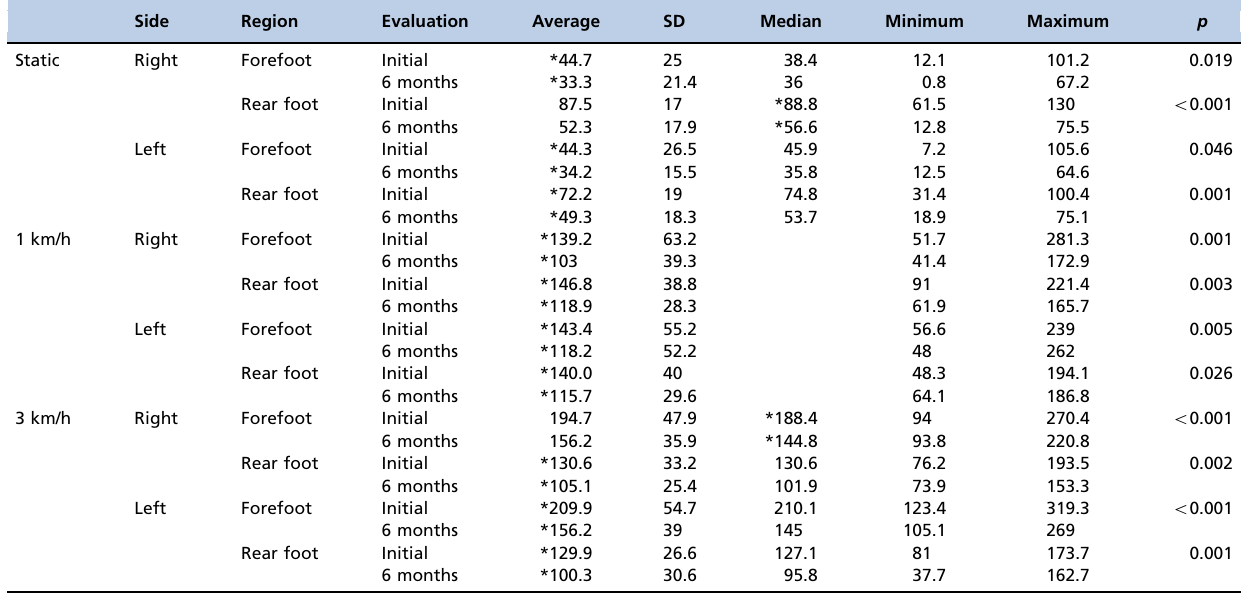
Table 2 - Descriptive statistics for the vertical component of the static and dynamic (1 and 3 km/h) ground reaction force (lb) measured at initial (initial) and final (six months after bariatric surgery) evaluations of the right and left feet, for the forefeet and rear feet of 16